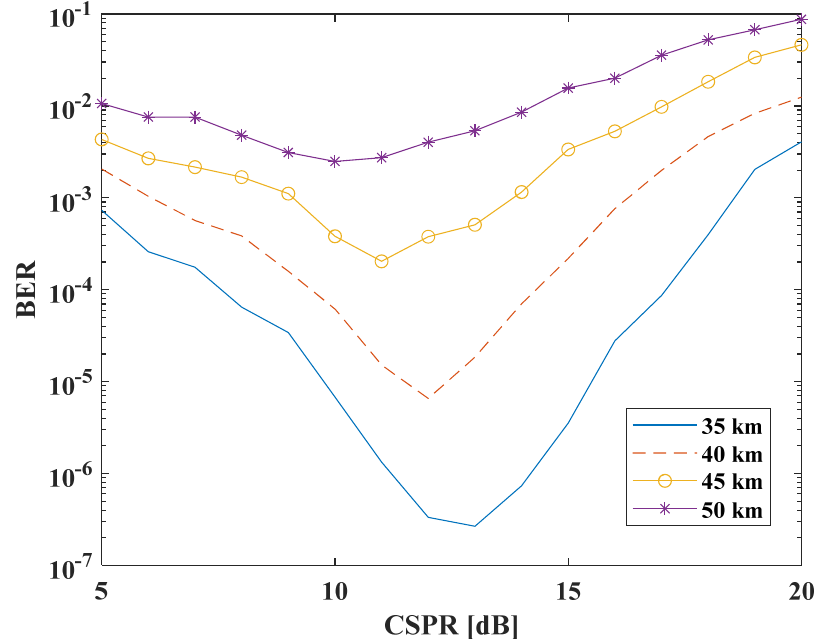
Figure 6. BER as a function of the CSPR and fiber length for 16 − QAM without ICXT.